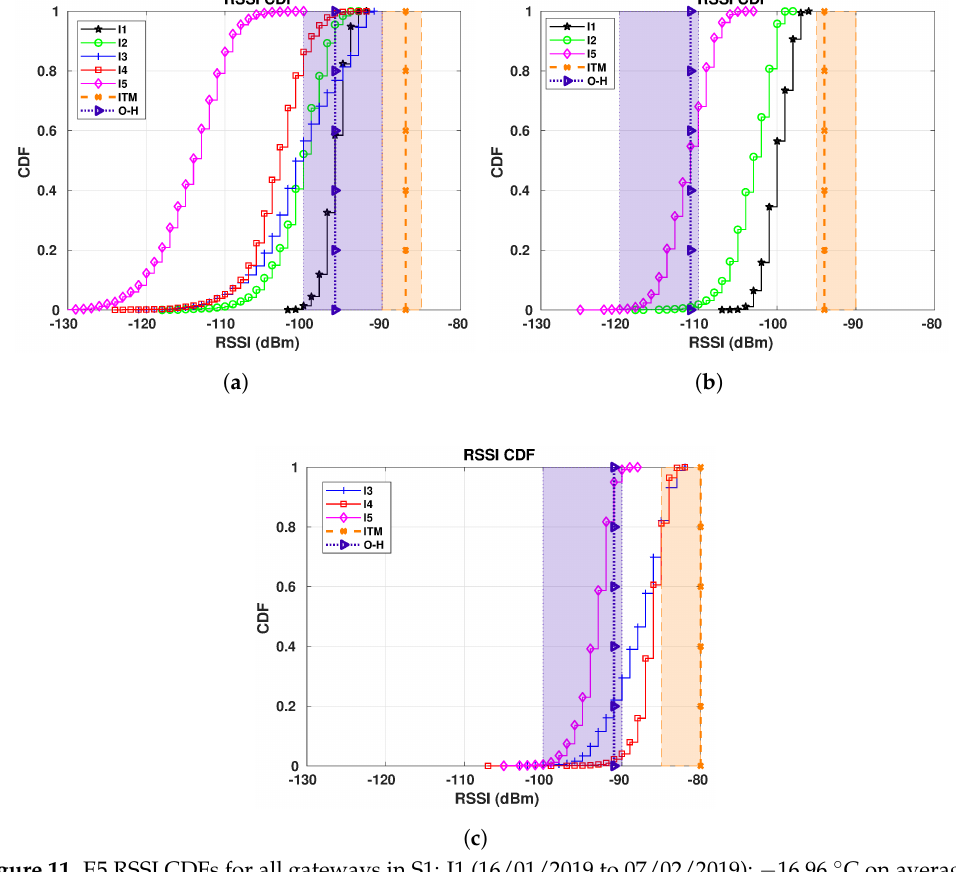
Figure 11. E5 RSSI CDFs for all gateways in S1: I1 (16/01/2019 to 07/02/2019): − 16.96 ◦ C on average; I2 (22/12/2018 to 06/01/2019): − 9.45 ◦ C on average; I3 (25/10/2018 to 04/11/20018): − 0.15 ◦ C on average; I4 (30/09/2018 to 14/10/2018): 6.56 ◦ C on average; I5 (15/05/2019 to 22/05/2019): 13.22 ◦ C on average. ( a ) E5 RSSI CDFs for GW1. ( b ) E5 RSSI CDFs for GW2. ( c ) E5 RSSI CDFs for GW4. Table 9. Summary of the main conclusions for E5 in S1 (values from Figure